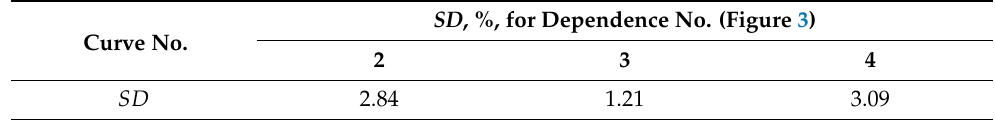
Table 1. Approximation quality of different descriptions of material properties. Curve